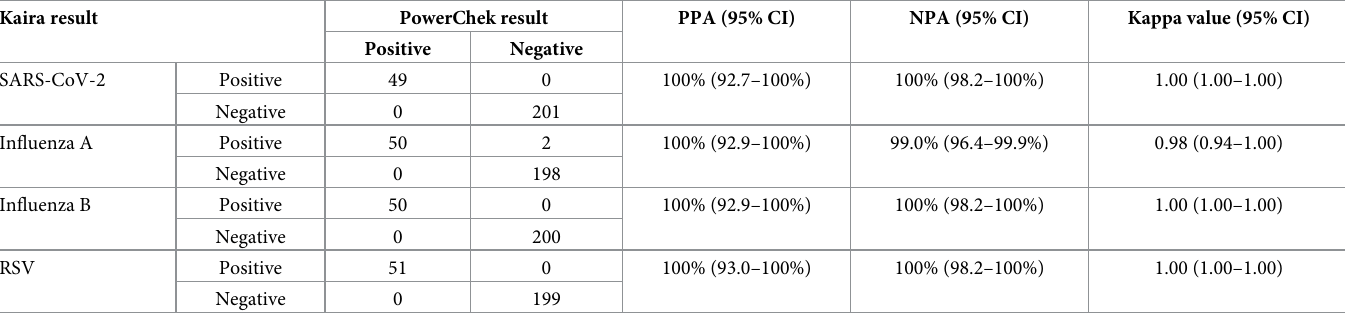
Table 3. Clinical performance of the Kaira assay in comparison with the PowerChek assay.